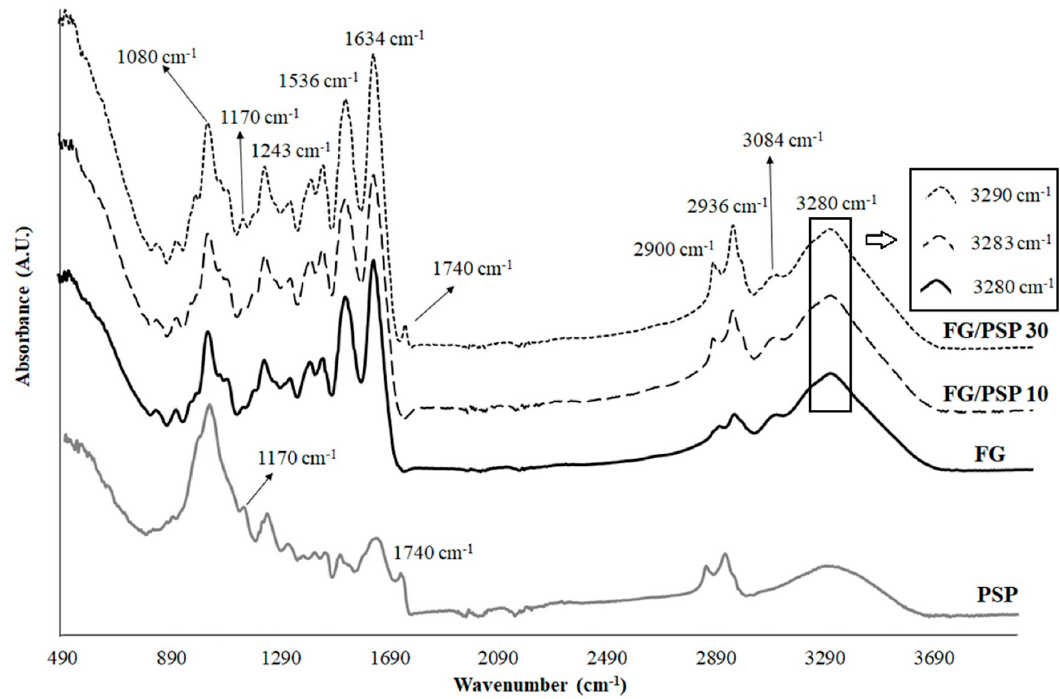
Figure 2. ATR-FTIR spectra of PSP and fish gelatin films containing PSP.